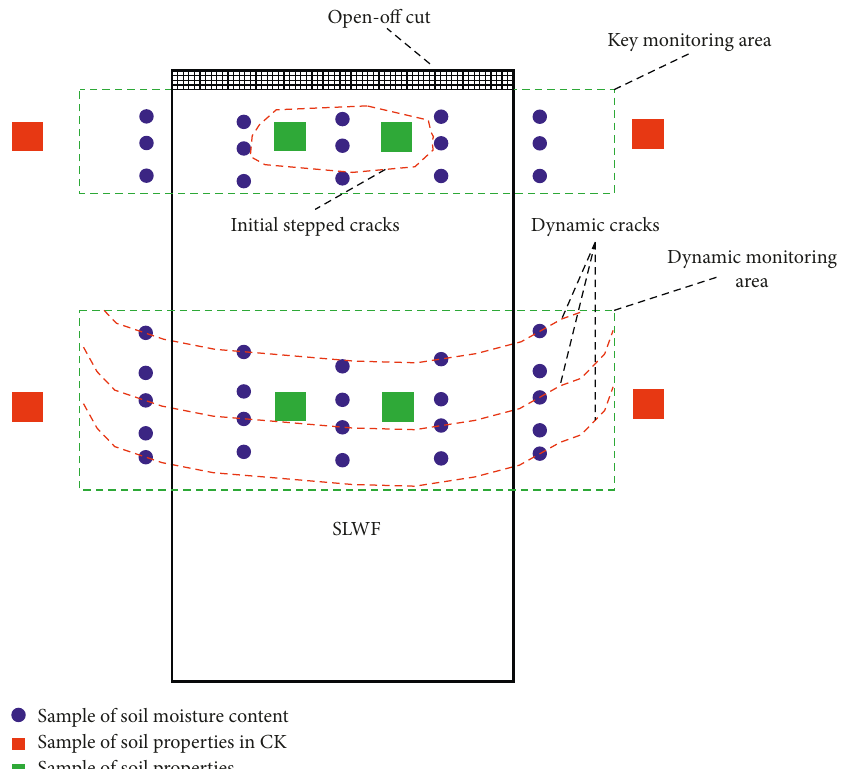
Figure 12: Optimized strategy of land ecology damages